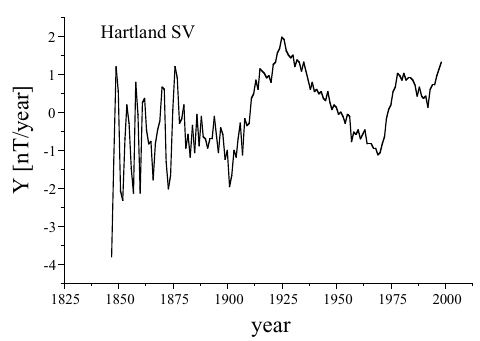
Fig. 5. Secular variation of the Y component of the geomagnetic field measured at Greenwich-Abinger- Hartland evaluated by